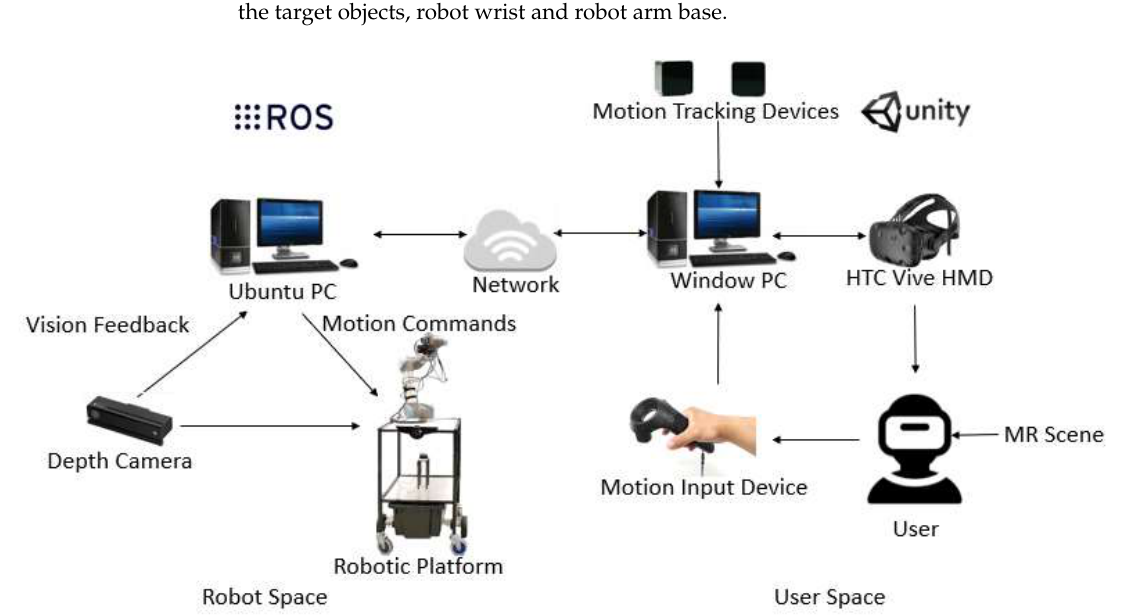
Figure 1. Schematic of the motion-mapping approach for the MR subspace-enhanced imitation-based HRI system of the teleoperated robotic arm-hand. ( a ) The robot working environment; ( b ) the MR scene displayed to the operator; ( c ) the user space. The MR subspace decouples the human from the robot, and the mappings for sensors and grippers are not necessarily direct and identical. The user’s eyes {E} and hand {H} and the state of the camera {C} as well as the robot arm’s grippers {G} are linked to each other through the MR subspace {S}, with {T}, {W}, and {B} denoting reference frames of the target objects, robot wrist and robot arm base.